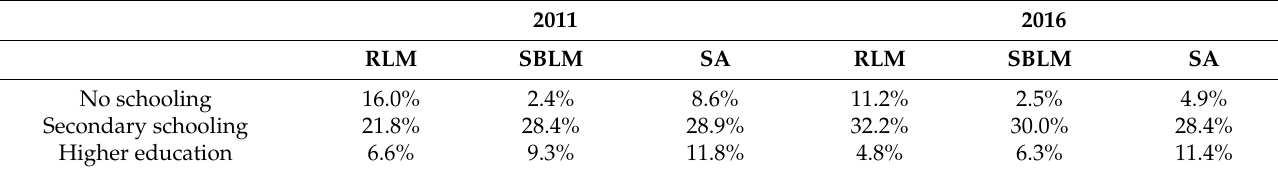
Table 4. Education in RLM and SBLM.